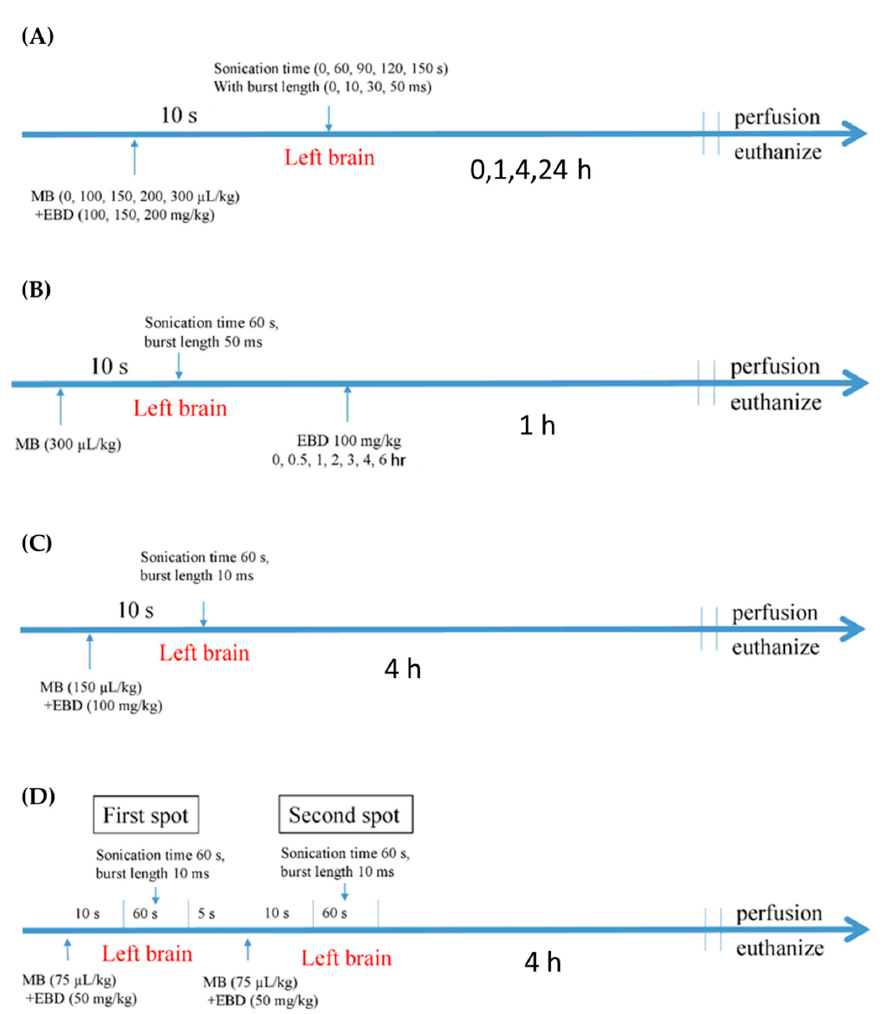
Figure 2. Sonication procedures. Acoustic pressure of 0.56 MPa and PRF of 1 Hz were used in all procedures. ( A ) Procedures of sonication in the parameter study; the experimental conditions are shown in Table 1. ( B ) Procedures of sonication in the BBBD dynamics study. ( C ) Procedures of